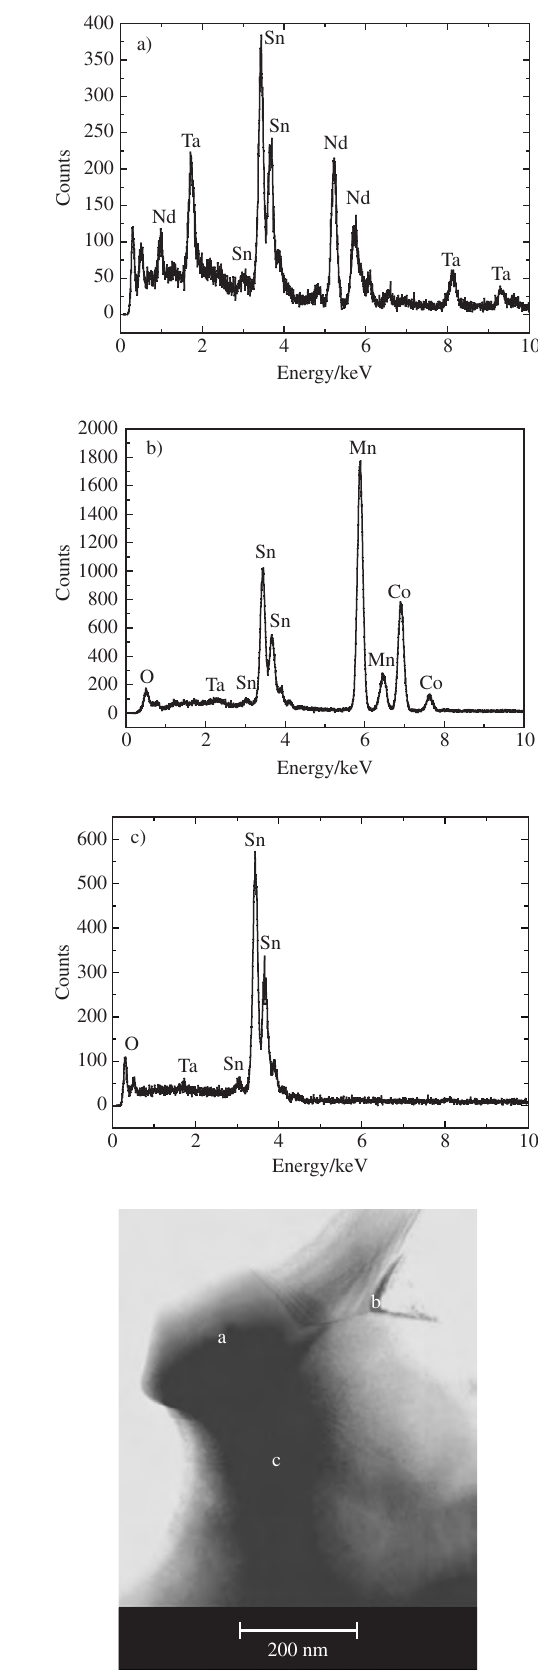
Figure 3. TEM and EDS spectra of the S2C7MT system. Figure 4. TEM and EDS spectra of the S2C7MTN